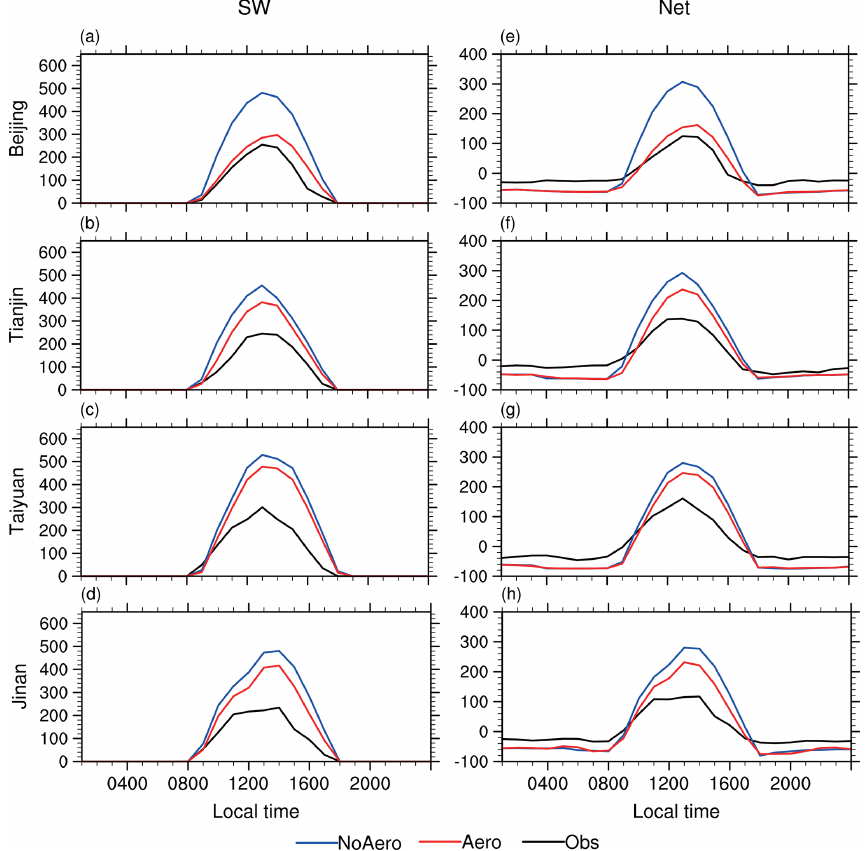
Figure 9. (a–d) Observed (black) and simulated (NoAero: blue, Aero: red) diurnal cycles of downward shortwave radiation at the sur- face (Wm − 2 ) averaged from 6 to 10 December 2015 at (a) Beijing, (b) Tianjin, (c) Taiyuan and (d) Jinan, respectively. Panels (e–h) are the same as (a–d) , but for net radiation at the surface (Wm − 2 ).